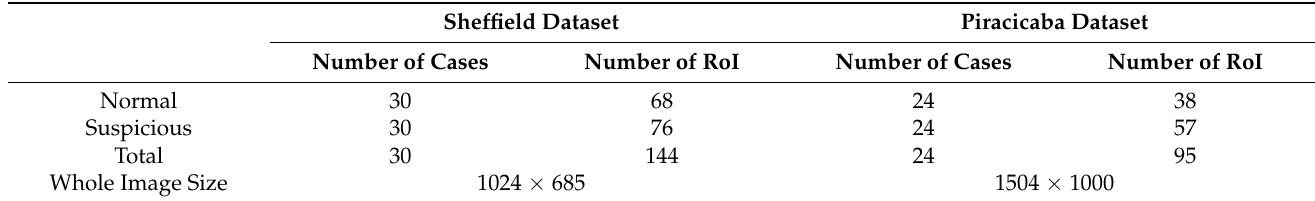
Figure 2. Differentiated “normal” and “suspicious” bounding box (rectangle) region from the original image according to the lined region. Table 1. Number of cases and RoI (region of interest) for normal and suspicious.